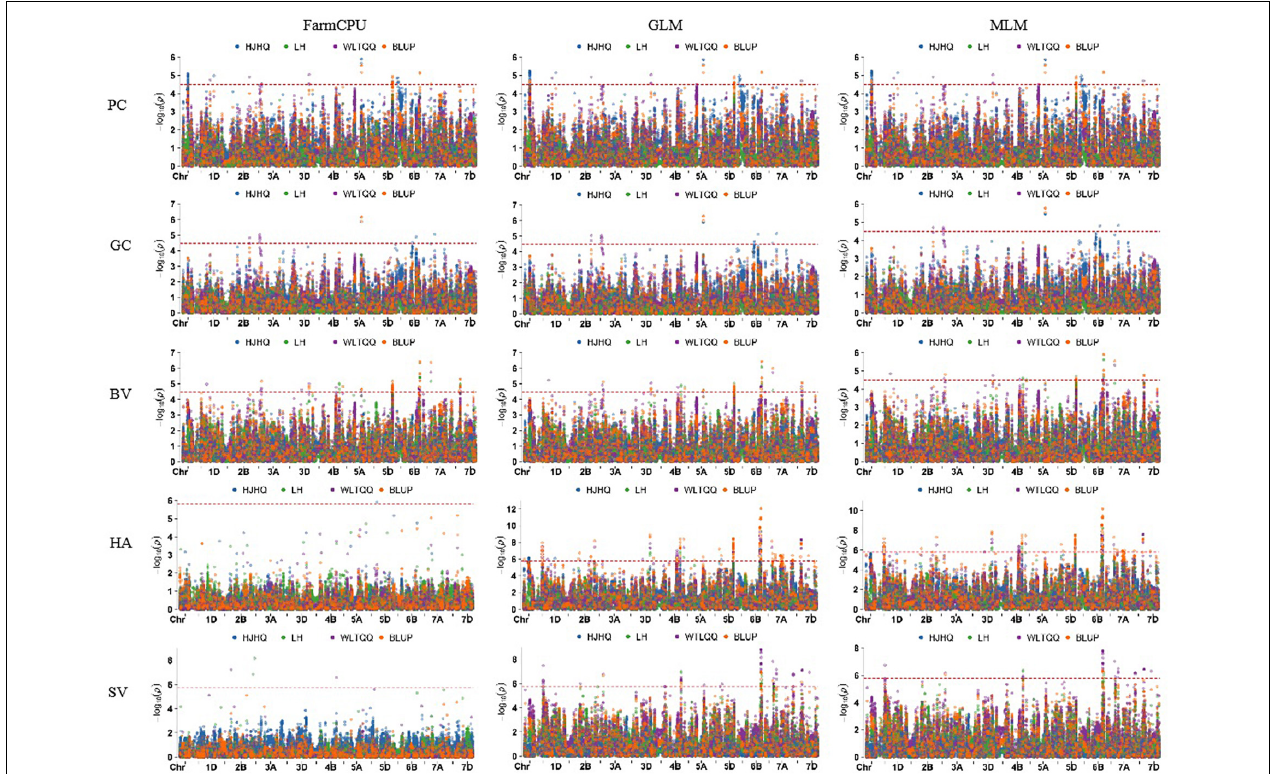
FIGURE 3 | Manhattan plots for five quality traits analyzed using three models and BLUP values as well as data from individual